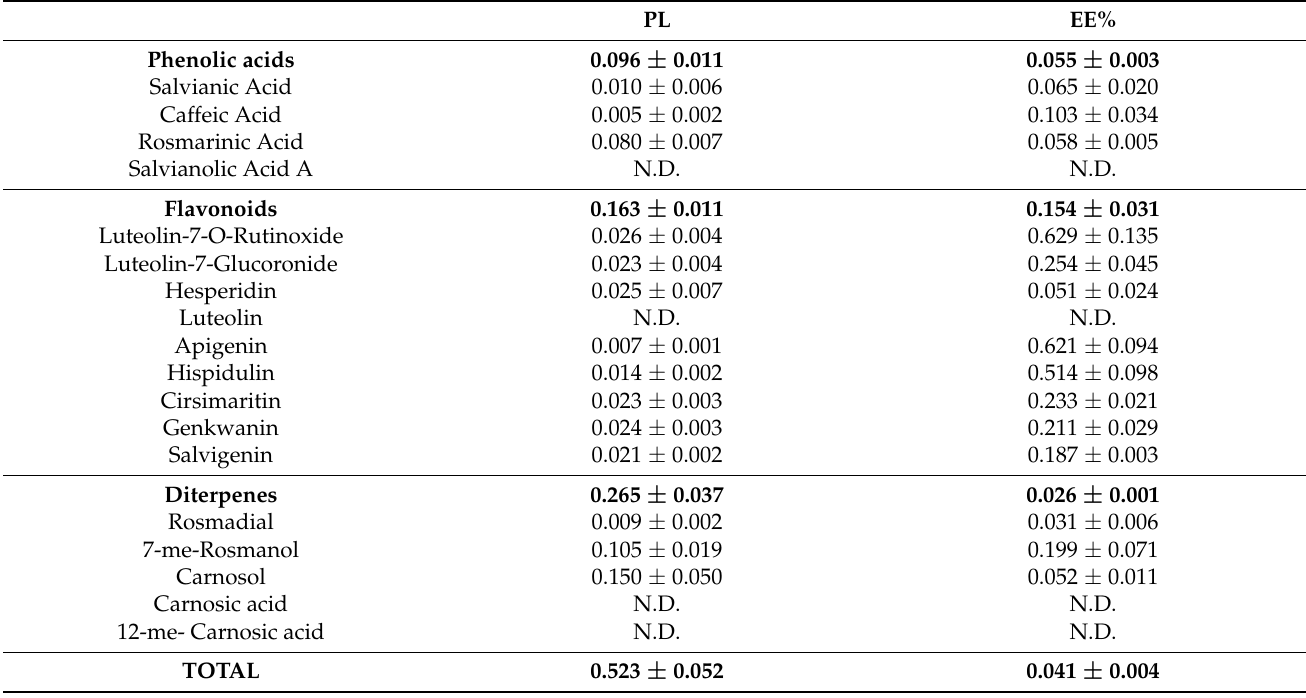
Table 4. Polyphenolic loading (PLC, µ g compound/mg RME-SFNs) and Encapsulation efficiency (EE, %) of the selected Rosemary extracts in RME–SFNs.